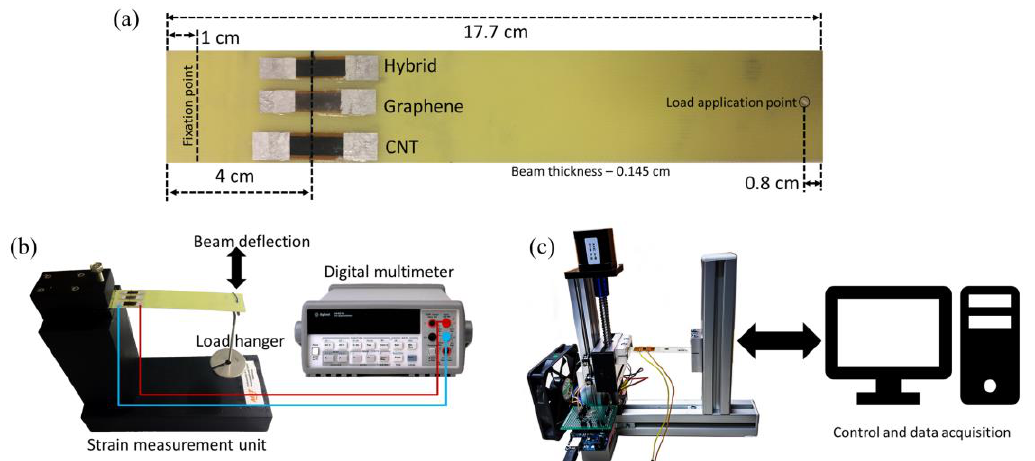
Figure 2. ( a ) Fabricated thin-film strain sensors attached to a FR4 beam, ( b ) experimental setup for strain measurement, and ( c ) automated strain measurement setup for the cyclic test.